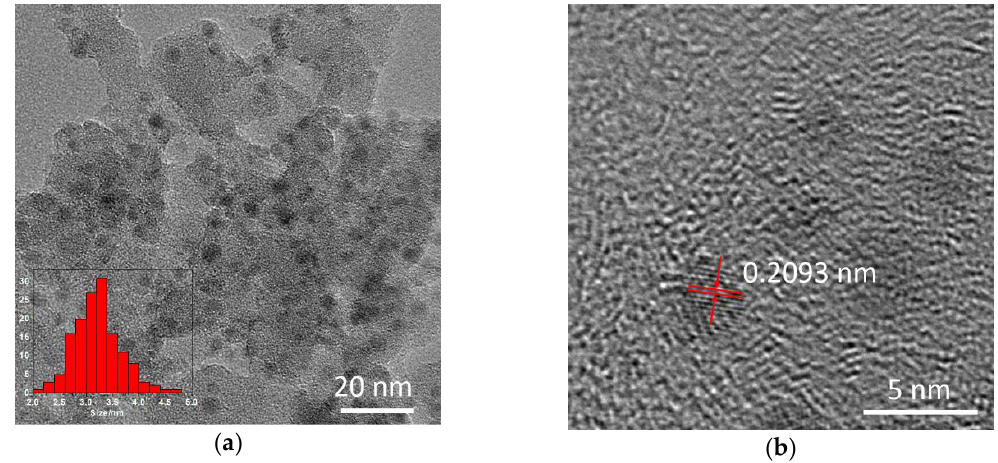
Figure 4. ( a ) Transmission Electron Microscopy (TEM) and ( b ) High-Resolution TEM (HRTEM) images of reduced Ni/SiO 2 .